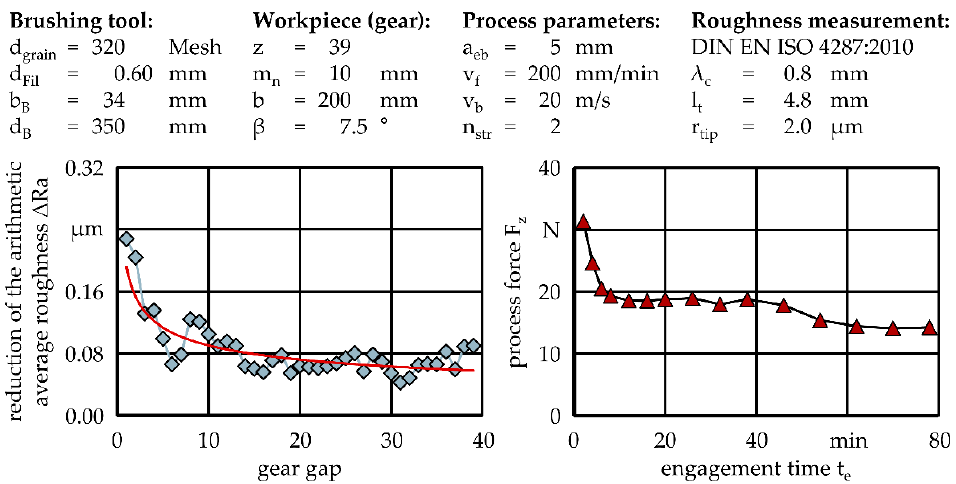
Figure 6. Reduction in the arithmetic average roughness Δ Ra and the correlating process force F z for the test series with tool specification S320x0.60 and an initial roughness of Ra ini ≅ 0.4 μ m. To qualitatively assess the wear of the brush filaments on a microscopic level, microscopies of individual filaments were taken after different processing times. When looking at the microscopic images of the individual filaments (S320x0.60) in Figure 7, it becomes clear that wear sets in rapidly and that the filament tips in particular are flattened after a short time. This correlates with the findings on the tool life of the S320x0.60 brushing tool. Consequently, there seems to be a direct correlation between the cutting ability of the filament tips and the removal rate of the entire brushing tool.